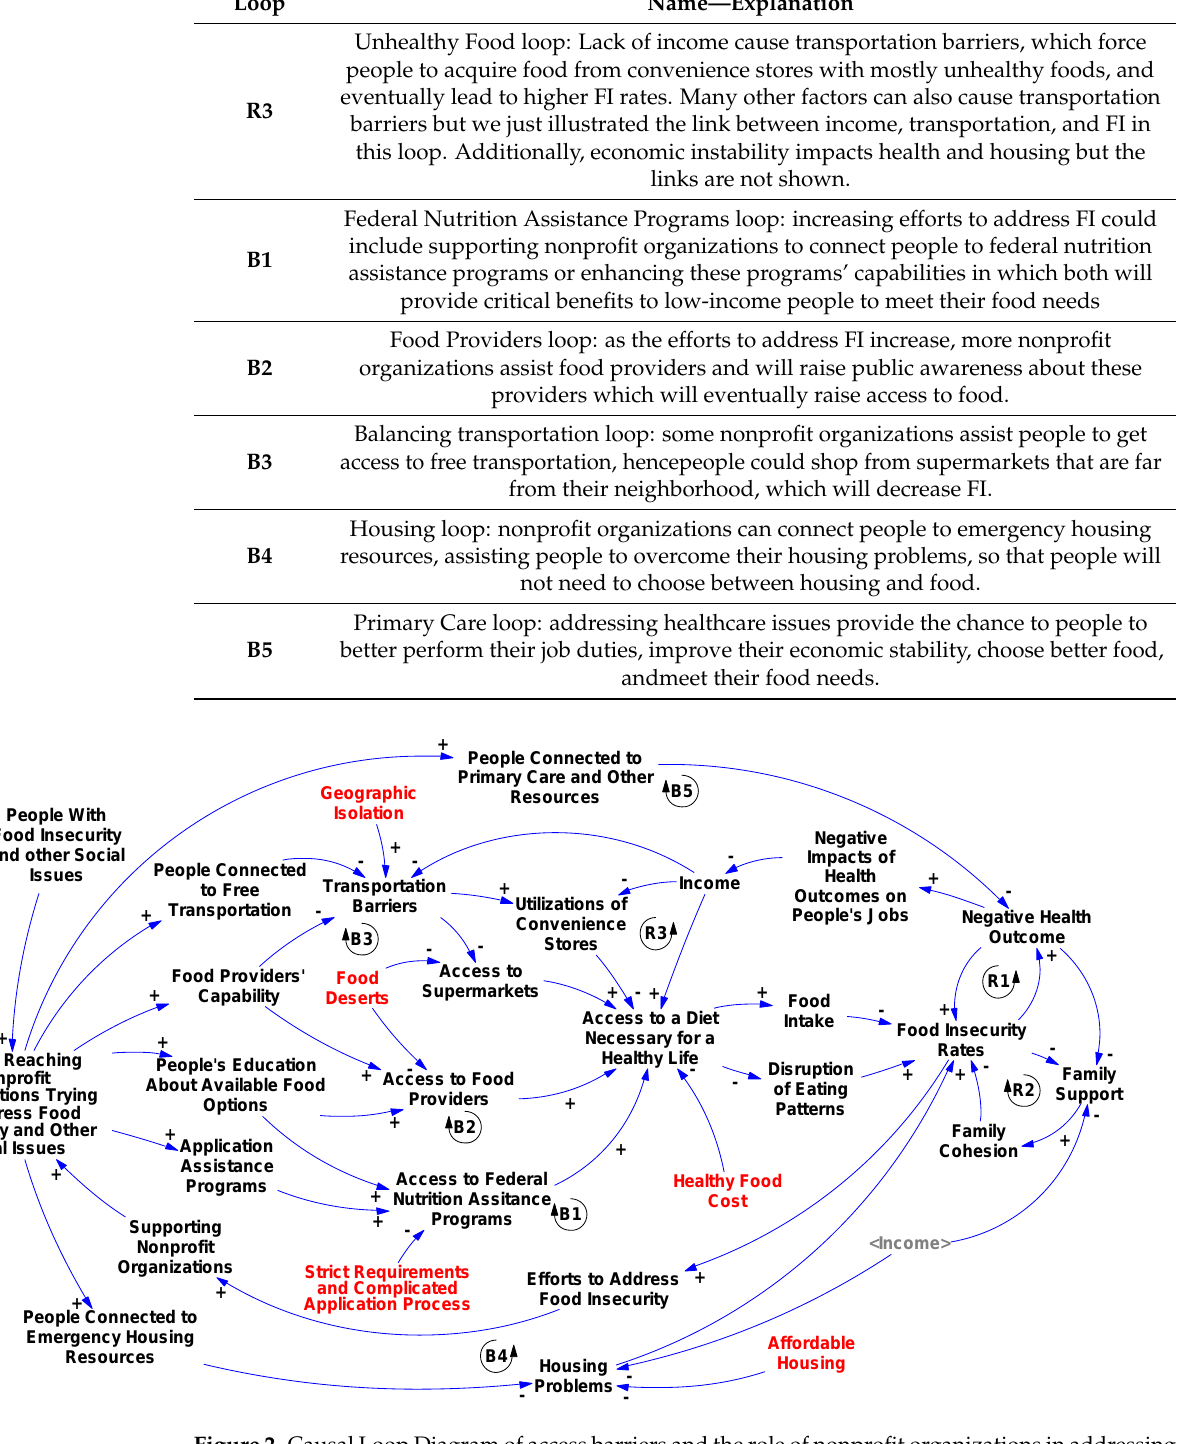
Figure 2. Causal Loop Diagram of access barriers and the role of nonprofit organizations in addressing social needs including food insecurity; red variables are exogenous variables that need policy changes. For illustration purposes, not all links are shown. Table 2. The list of highlighted reinforcing (R) and balancing (B) loops in Figure 2.